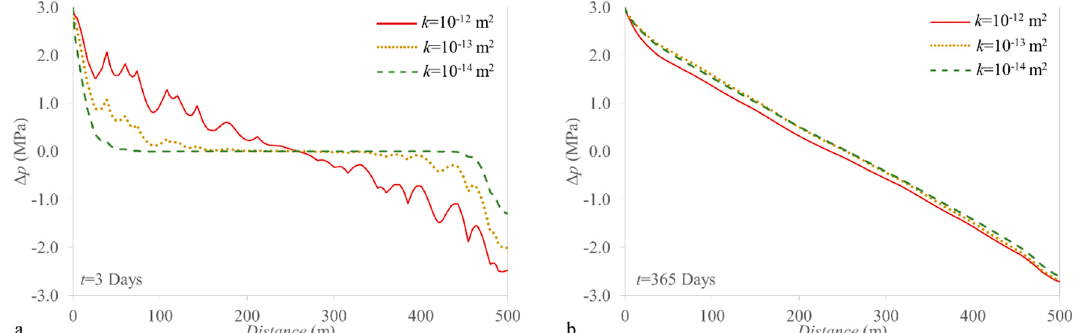
Figure 3. Fluid pressure changes along the horizontal direction in the reservoir ( a ) after 3 days of injection and ( b ) after 1 year of injection. Note that the fluctuations are due to the larger pressure changes that occur in the fractures with respect to the reservoir matrix.